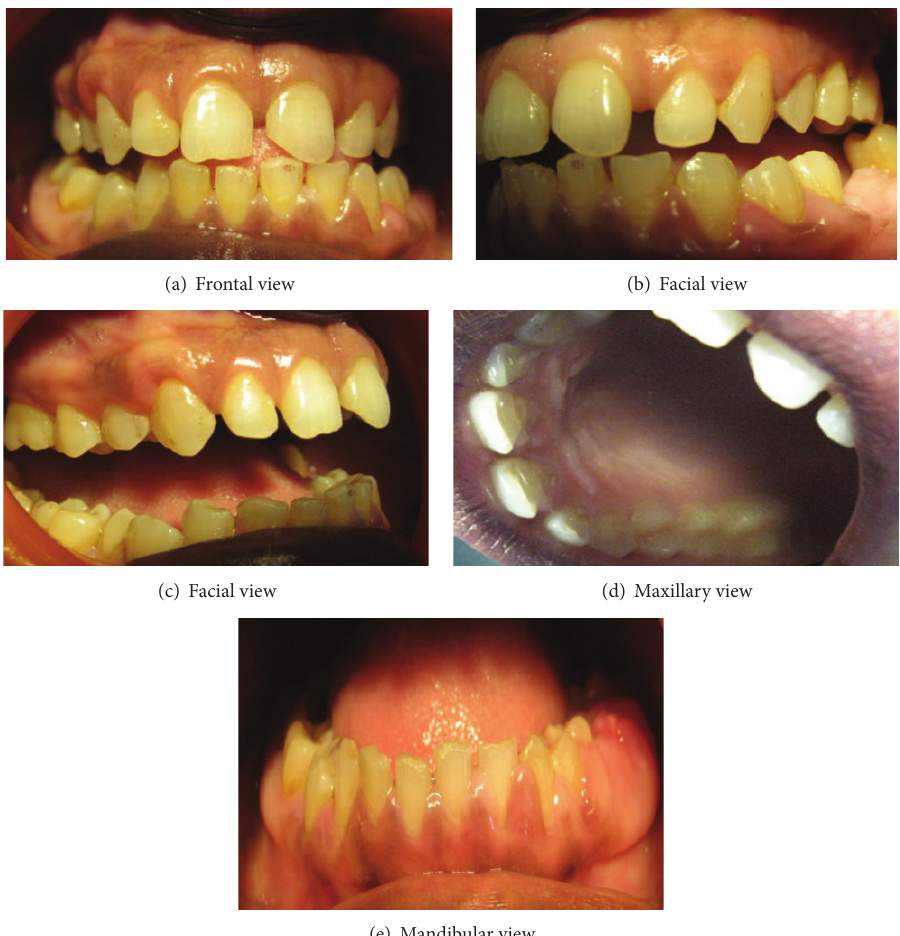
Figure 3: Postoperative intraoral picture of generalized gingival